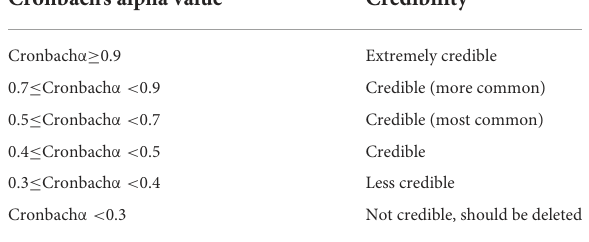
TABLE 1 Cronbach alpha test